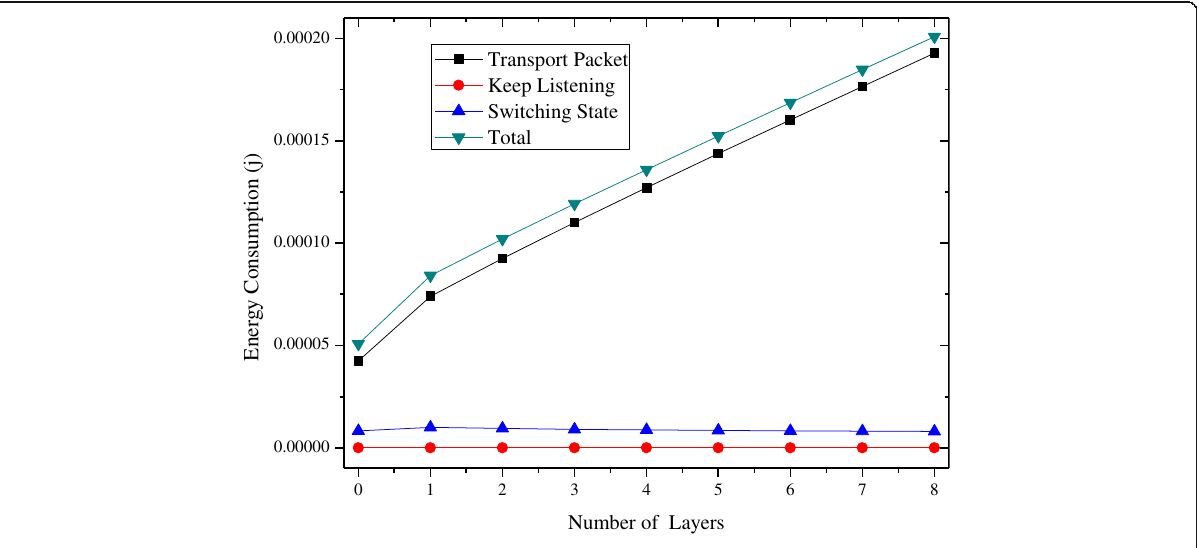
Fig. 16 Energy consumption without DEEDC scheme